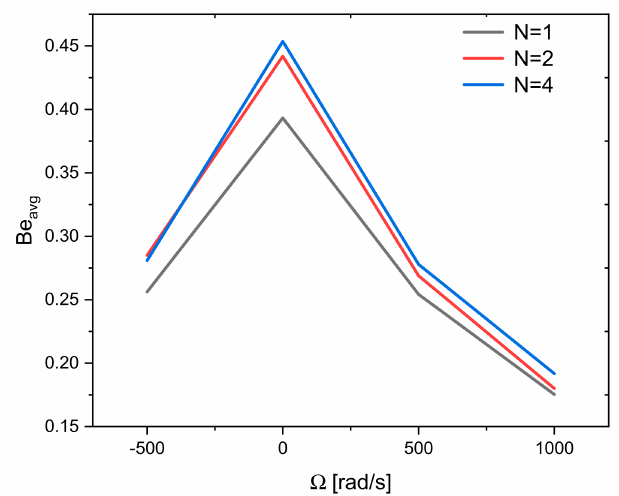
Figure 12. Effect of the values and direction of the cylinder rotation on the average Bejan number for three zigzags number of the hot